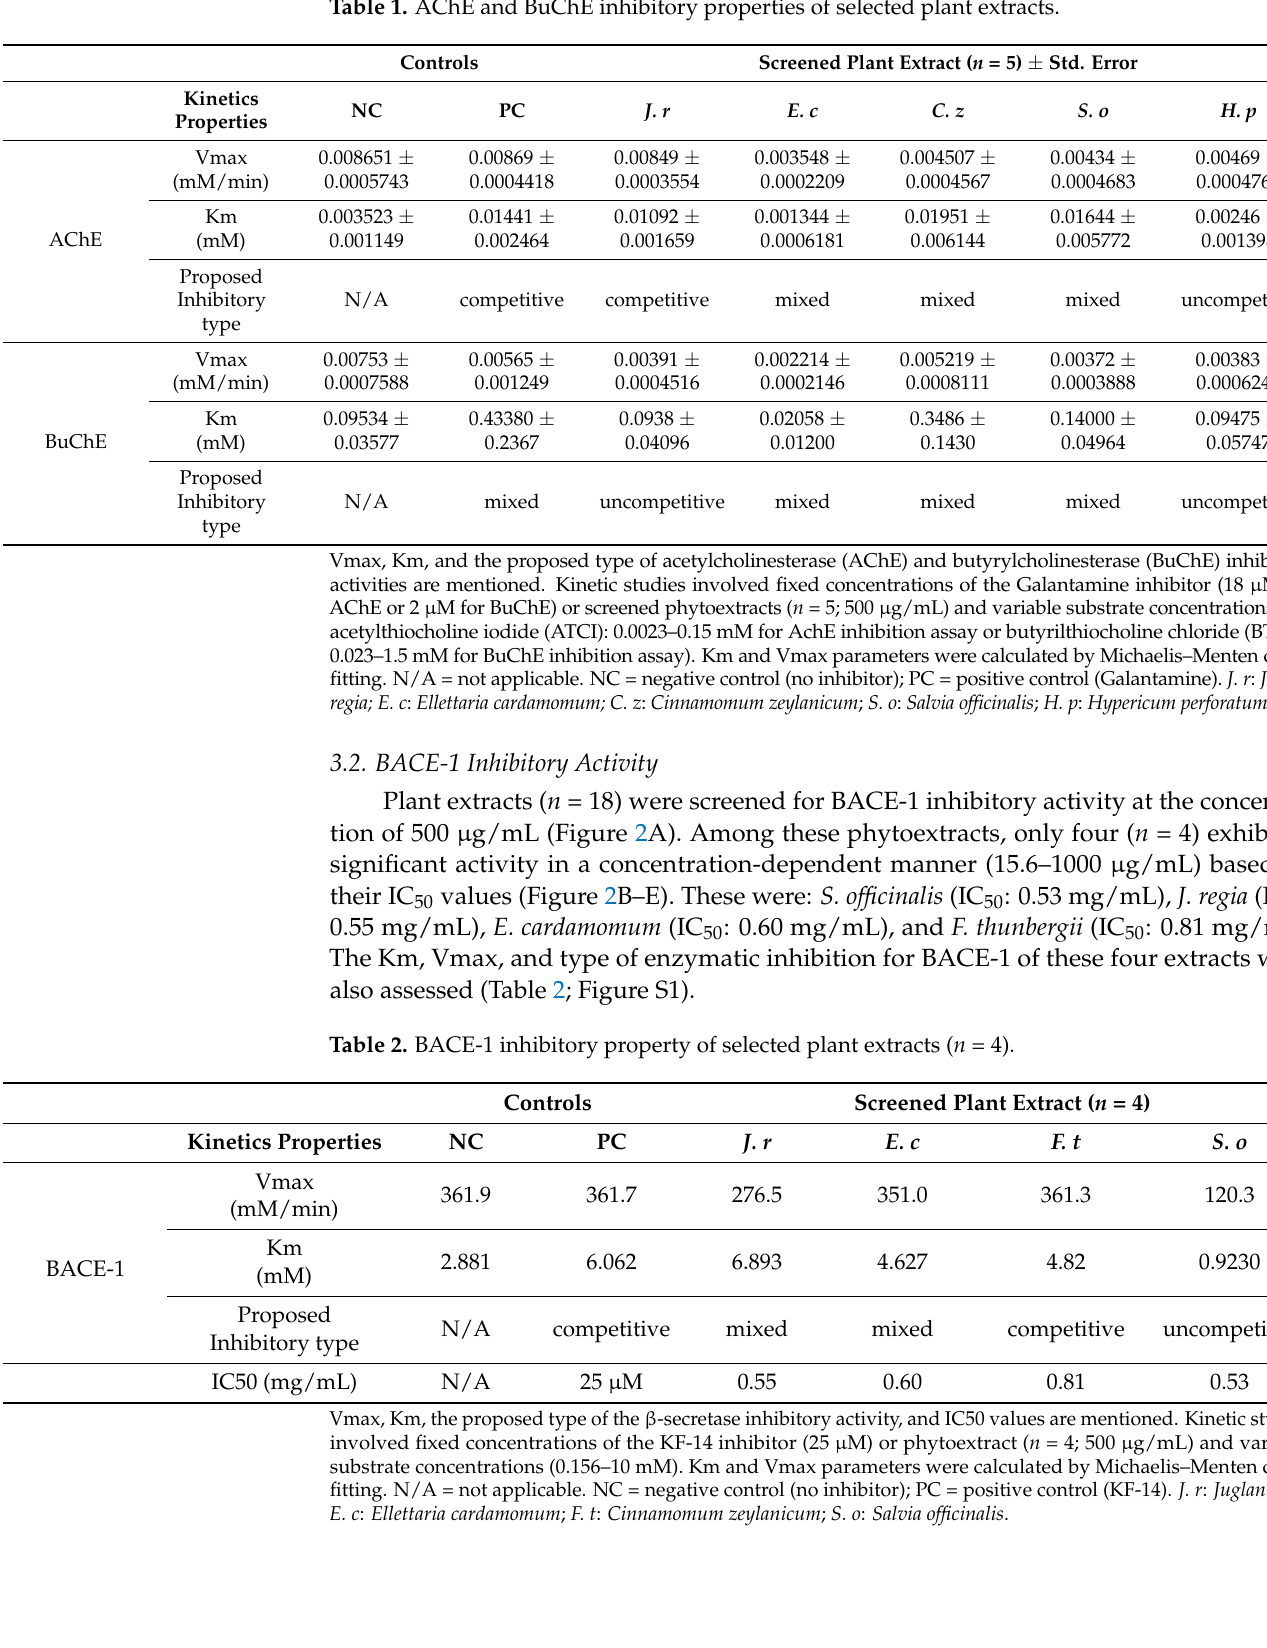
Table 1. AChE and BuChE inhibitory properties of selected plant extracts.